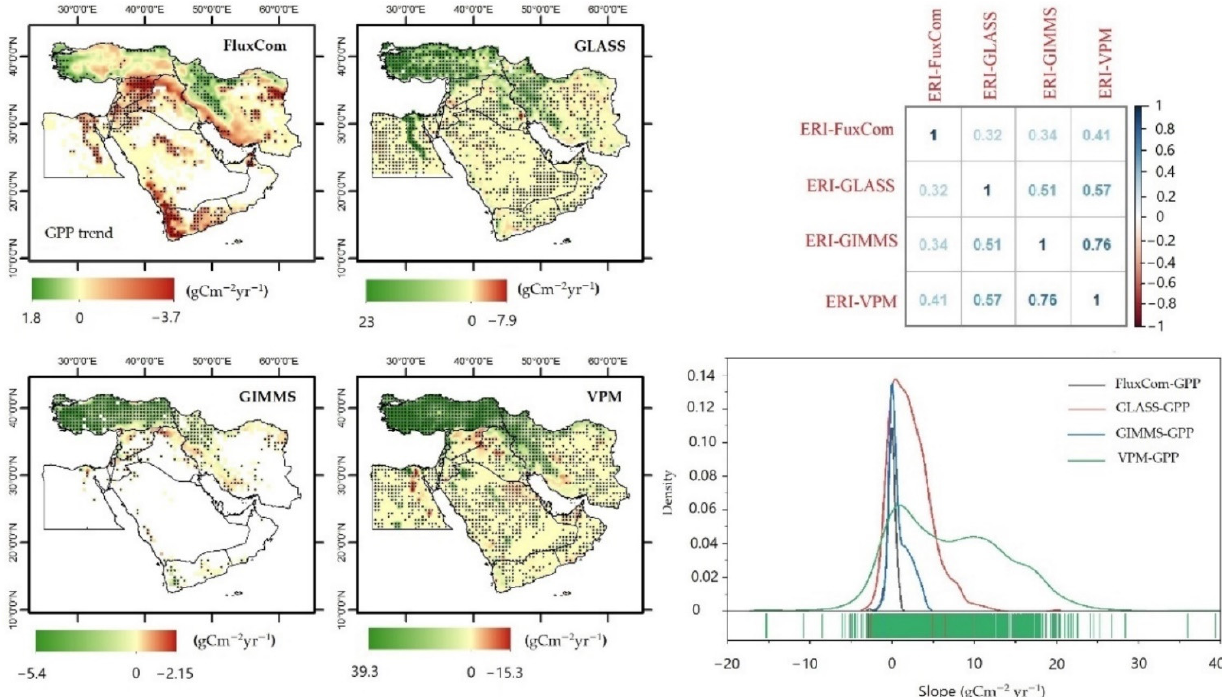
Figure 5. The left panel shows the spatio-temporal trends of the GPP products (in gC m − 2 yr − 1 ) for the Middle East between 1982 and 2016. The small dots denote statistically significant trends at a confidence level of 95% (i.e., p < 0.05) using the Z-statistic of the M-K test. The upper right panel summarizes the cross-correlation matrix calculated among the models’ trend magnitudes (Sen’s slopes), while the lower right panel shows the distribution density curve of the trend slope for all GPP products.